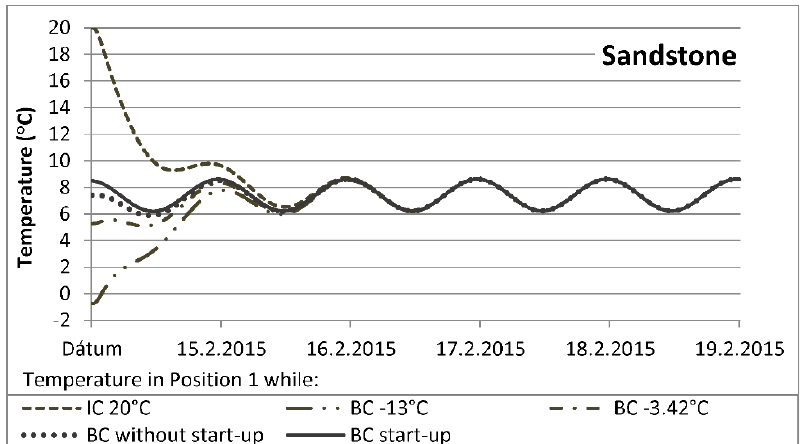
Figure 8. Plotted temperature courses of the simple sandstone test wall S3 in Position 1, according to Table 2 and Figure 5b during the chosen time period.